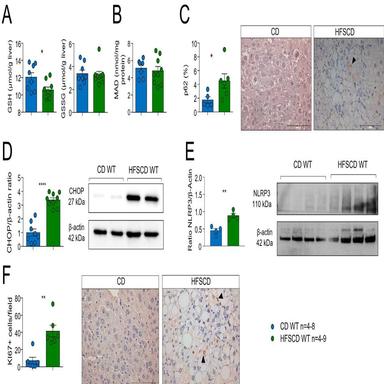
The feeding of WT mice with the HFSCD produced important changes in hepatic autophagy, oxidative and ER stress and proliferation. Hepatic content of (A) reduced glutathione (GSH), oxidized glutathione (GSSG) and (B) MDA in both mouse groups. (C) Content of p62 protein, measured as relative area to tissue area, in hepatic crosssections from WT mice fed control and HFSCD. (D) CHOP protein and (E) NLRP3 protein levels determined by western blot analysis in both mouse groups. (F) Number of proliferant Ki67+ cel